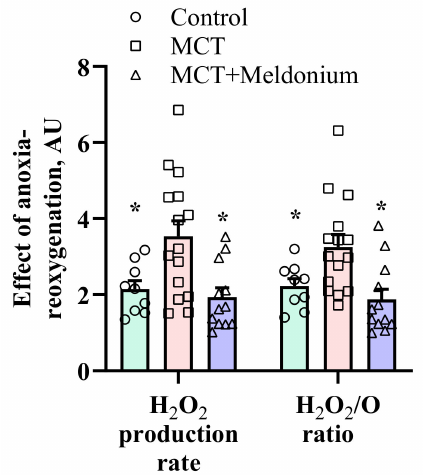
Figure 3. The effects of meldonium treatment (200 mg/kg for 4 weeks) on mitochondrial func- tion/reactive oxygen species (ROS) production after in vitro anoxia-reoxygenation in left ventricular (LV) cardiac fibers in a model of pulmonary hypertension-induced right ventricle heart failure. Anoxia-reoxygenation induced a significantly higher H 2 O 2 production rate and H 2 O 2 /O ratio in the monocrotaline (MCT) group than in the control group. Treatment with meldonium decreased anoxia-reoxygenation-induced H 2 O 2 production to the level of the control group. The data are shown as the mean ± SEM of 9 to12 experiments. * p < 0.05 vs. MCT group, one-way ANOVA with Dunnett’s multiple comparisons